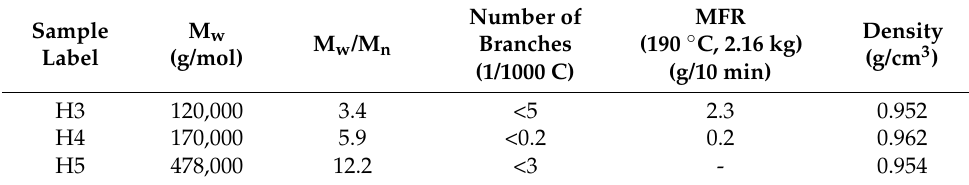
Table 1. Molecular characteristic of polyethylene samples used